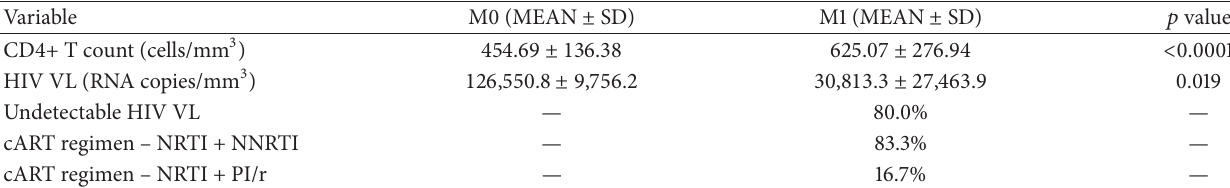
Table 1: Clinical data of 30 PLWHA before and after cART